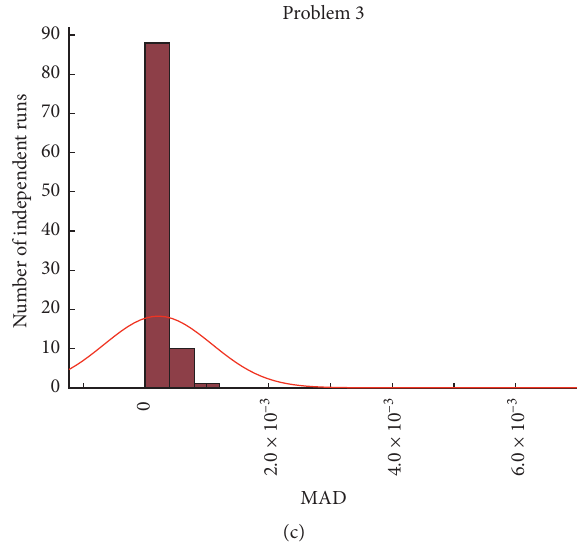
Figure 8: Normal probability plots of fitness values obtained during 100 experiments for Problem 1–3.